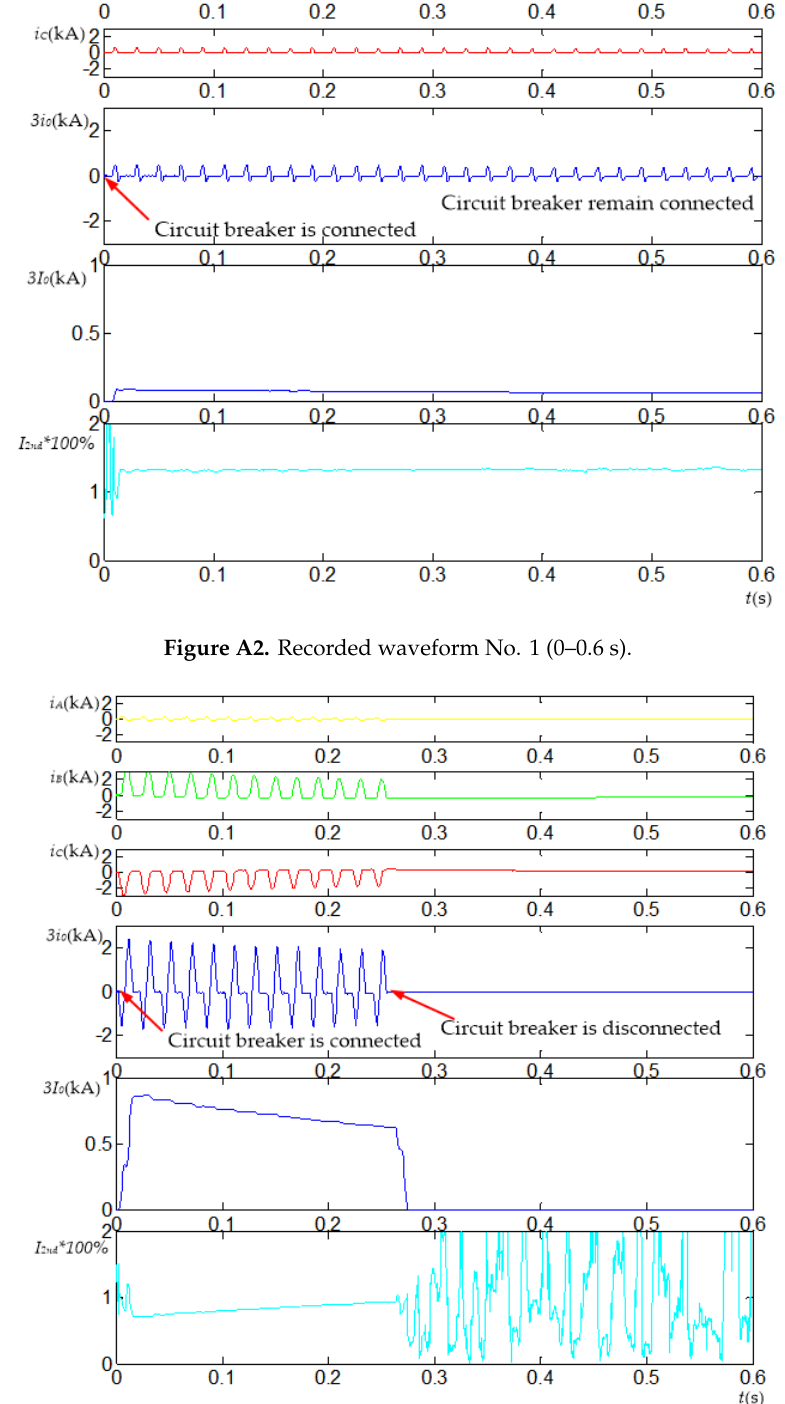
Figure A3. Recorded waveform No. 2 (0 s – 0.6 s).